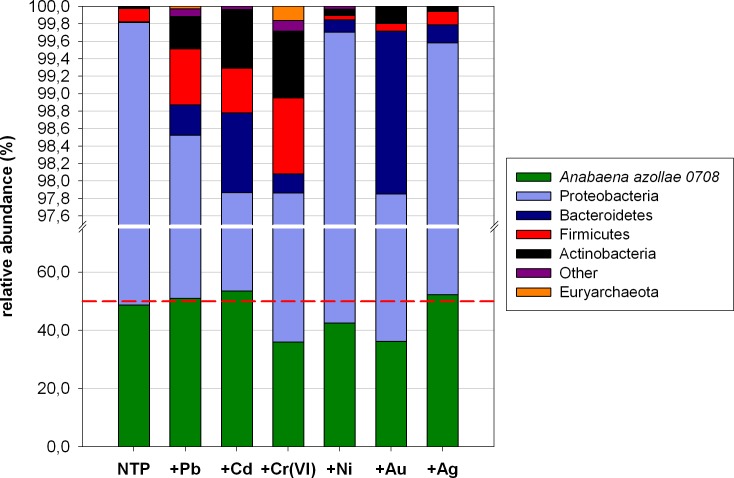
The relative abundance of bacteria at the phylum level across all samples.